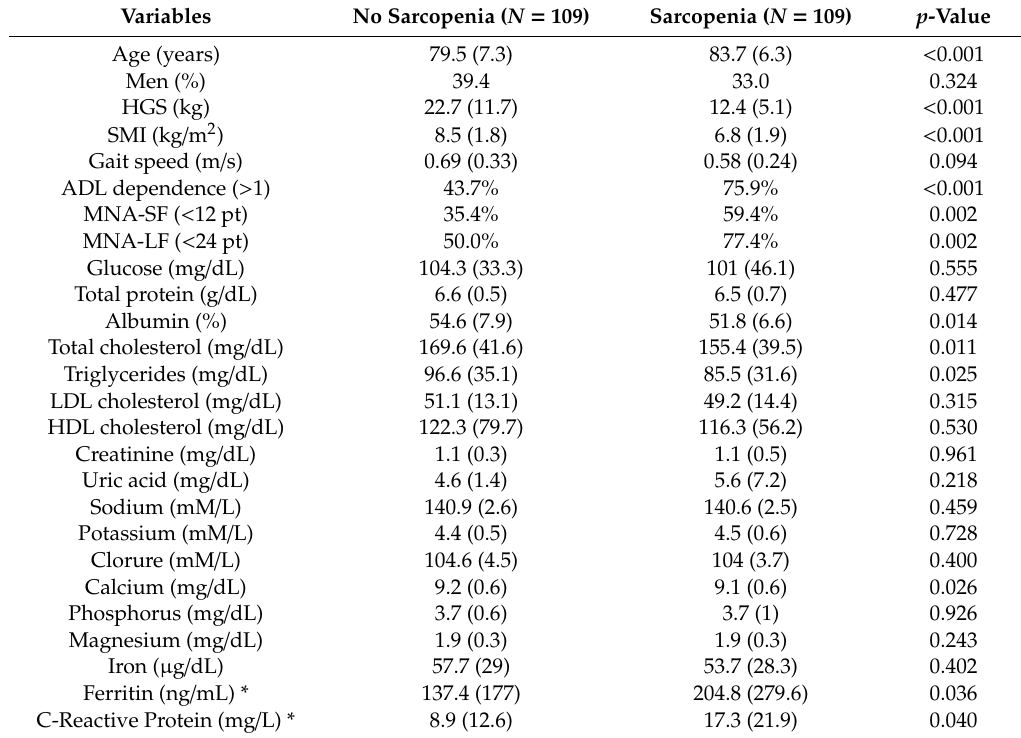
Table 1. Anthropometric and biochemical characteristics of participants with and without